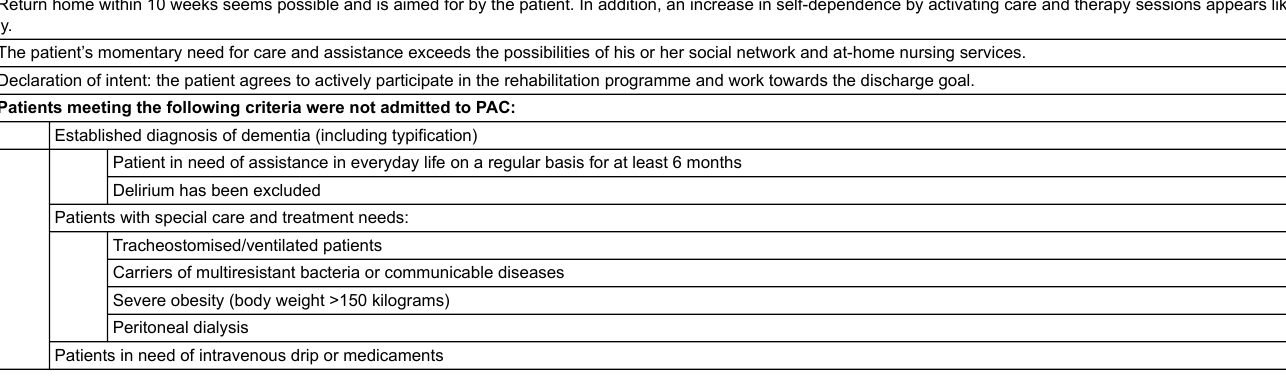
Table S1: Admission criteria * for post-acute care units.